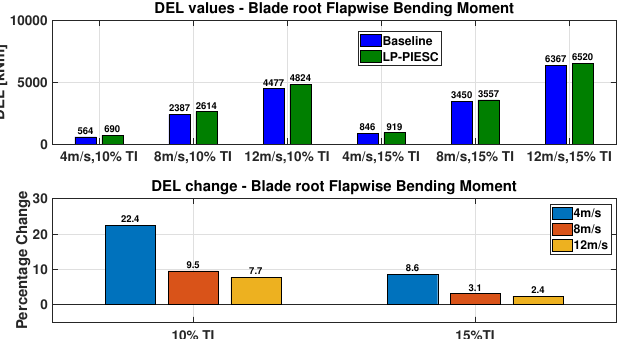
Figure 29. Blade root flap-wise bending moment comparison: Baseline vs. LP-PIESC. Aggregate DEL values with baseline controller and LP-PIESC ( top ), percentage change in DEL ( bottom ) for time series from 150 s to 3000 s.